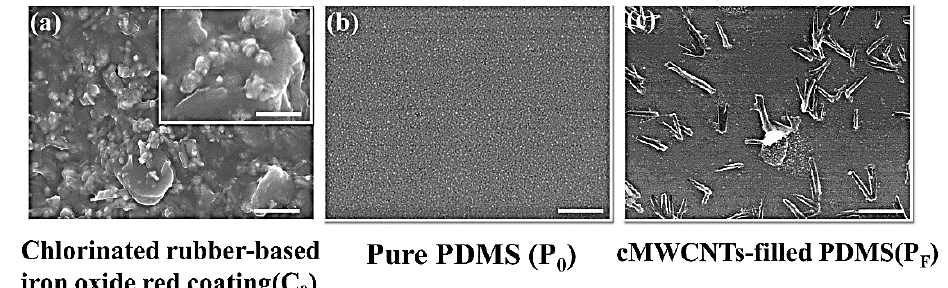
Figure 1. The scanning electron microscope (SEM) images of the three coatings (i.e., C 0 , P 0 and P F surfaces.) before immersion for comparison. The scale bars are 2 µ m in main figures, and 200 nm in inset.